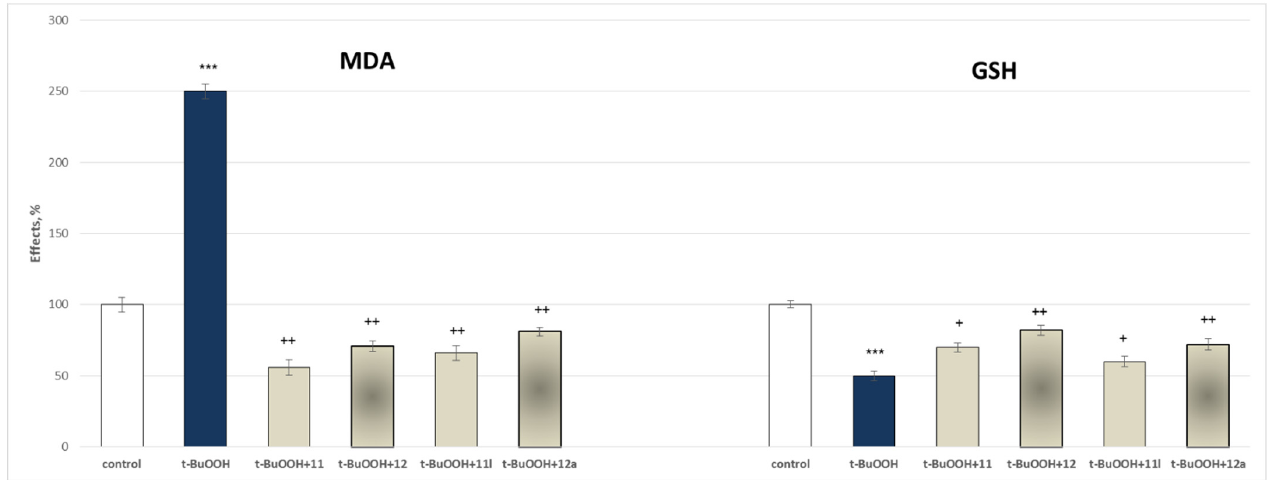
Figure 10. Effects of 11 , 11l , 12 and 12a in a model of t -BuOOH-induced oxidative stress on MDA production and GSH levels in isolated rat brain mitochondria. *** p < 0.001 against the control (untreated mitochondria), + p < 0.05; ++ p < 0.01 against t -BuOOH.